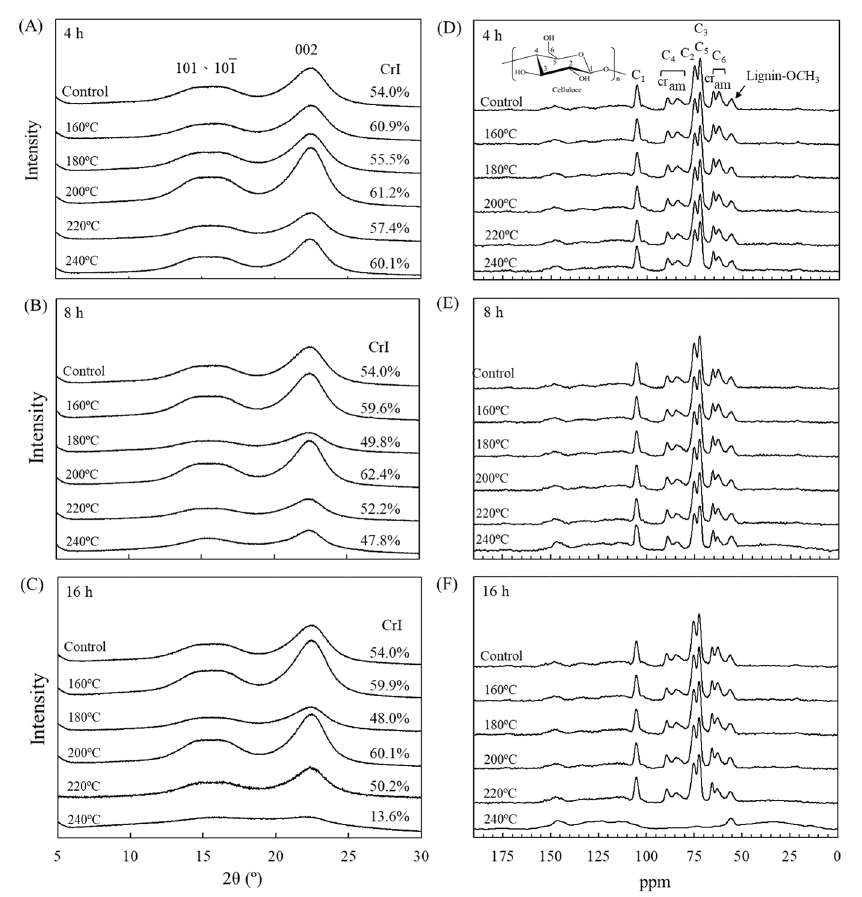
Figure 2. XRD ( A – C ) and NMR ( D – F ) spectra of luanta fir wood before and after VH treatment at different temperatures for ( A , D ) 4, ( B , E ) 8, and ( C , F ) 16 h.